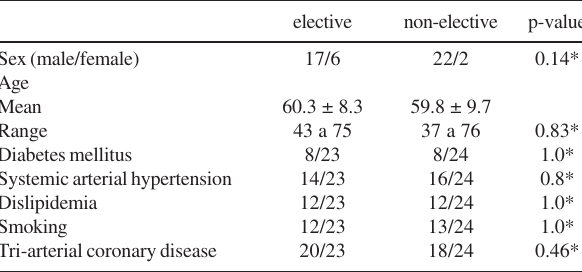
Table 1 - Pre-operative characteristics of patients in this study